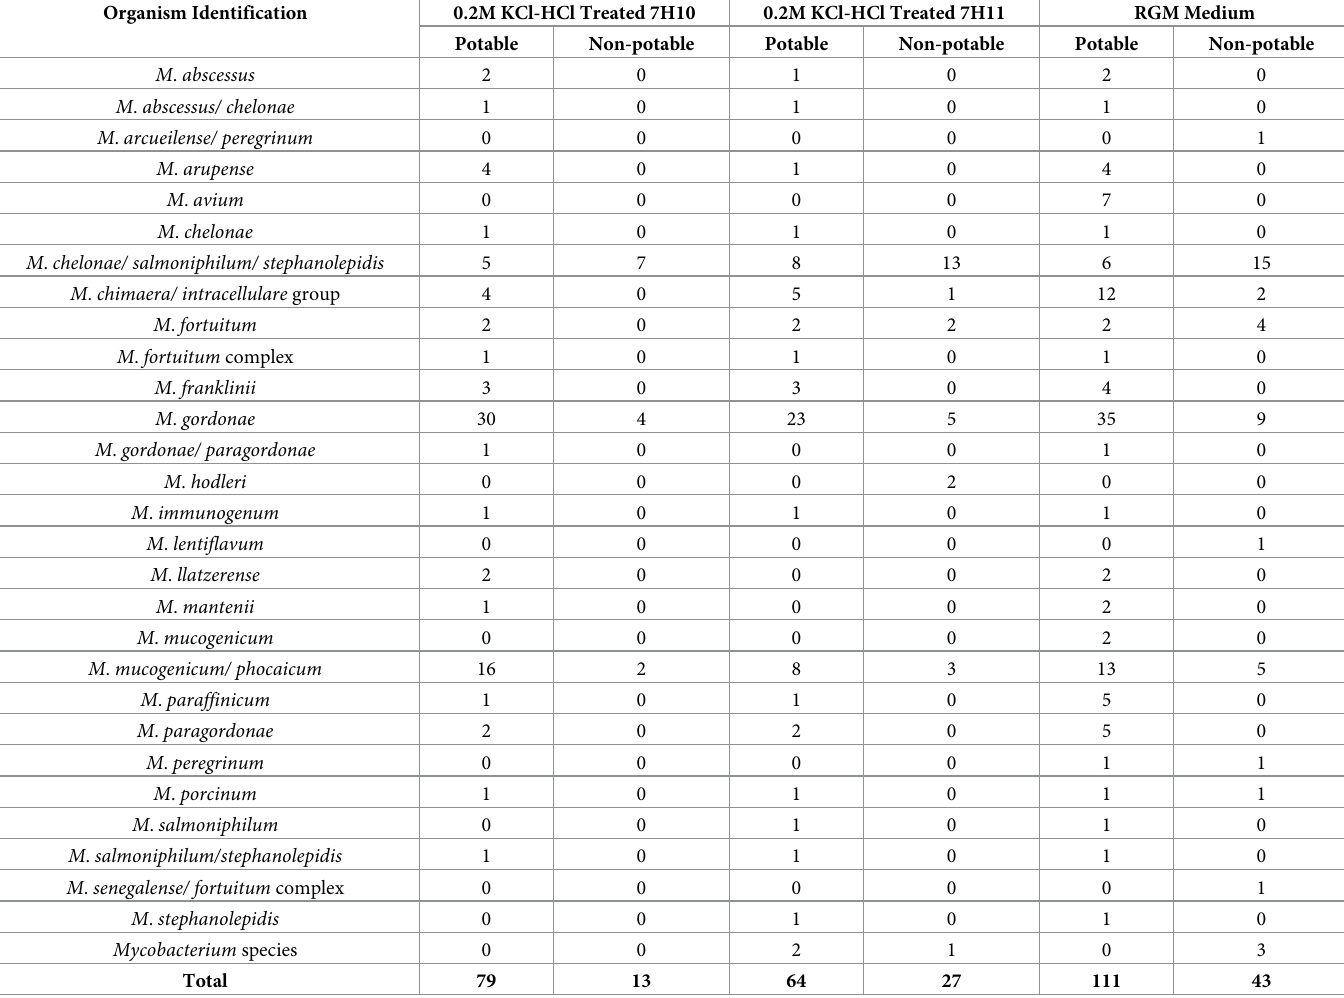
Table 2. Identification of mycobacterial species on 7H10, 7H11, and RGM medium. Organism